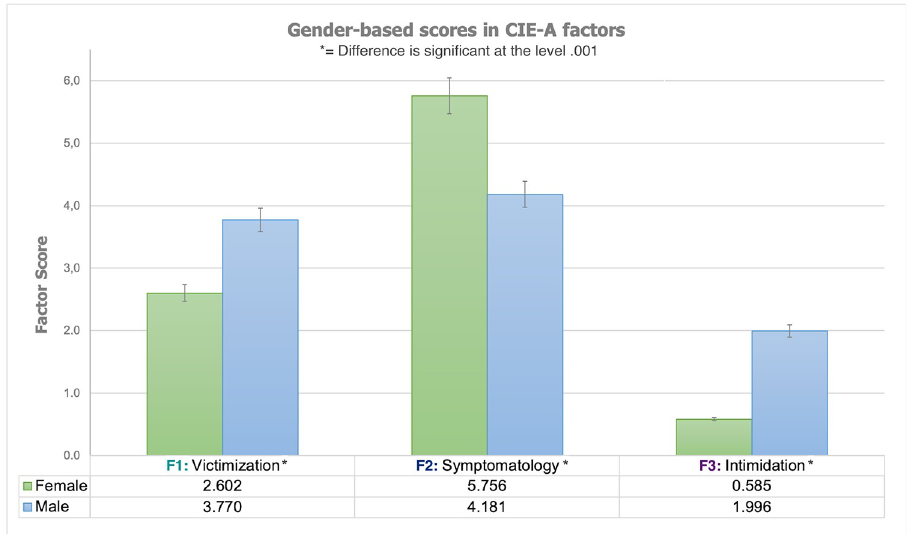
Fig 2. Gender differences. Gender-based score comparisons for the three CIE-A dimensions. Compared values represent aggregate scale scores.